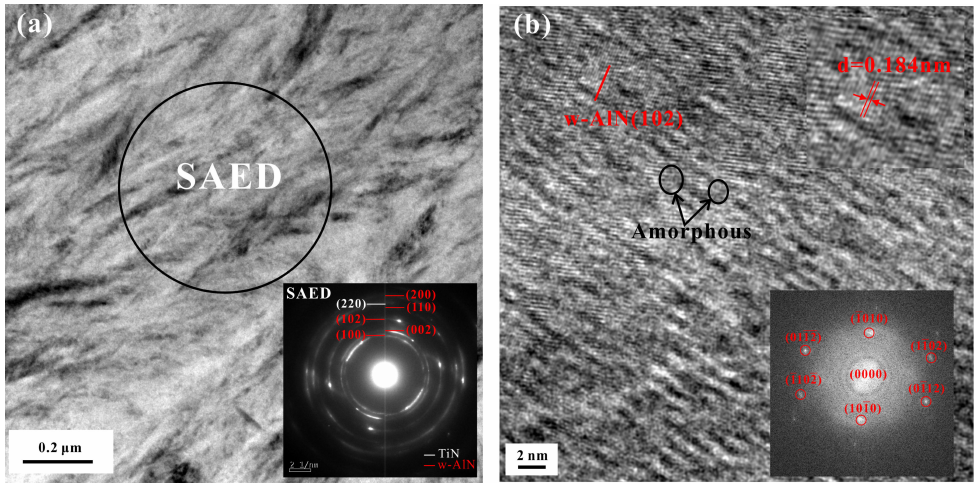
Figure 6. Cross-sectional TEM images of PVD Ti 0.31 Al 0.60 Si 0.09 N coatings. ( a ) A bright field TEM image with an SAED pattern in the inset and ( b ) HRTEM image and FFT pattern of the coating.